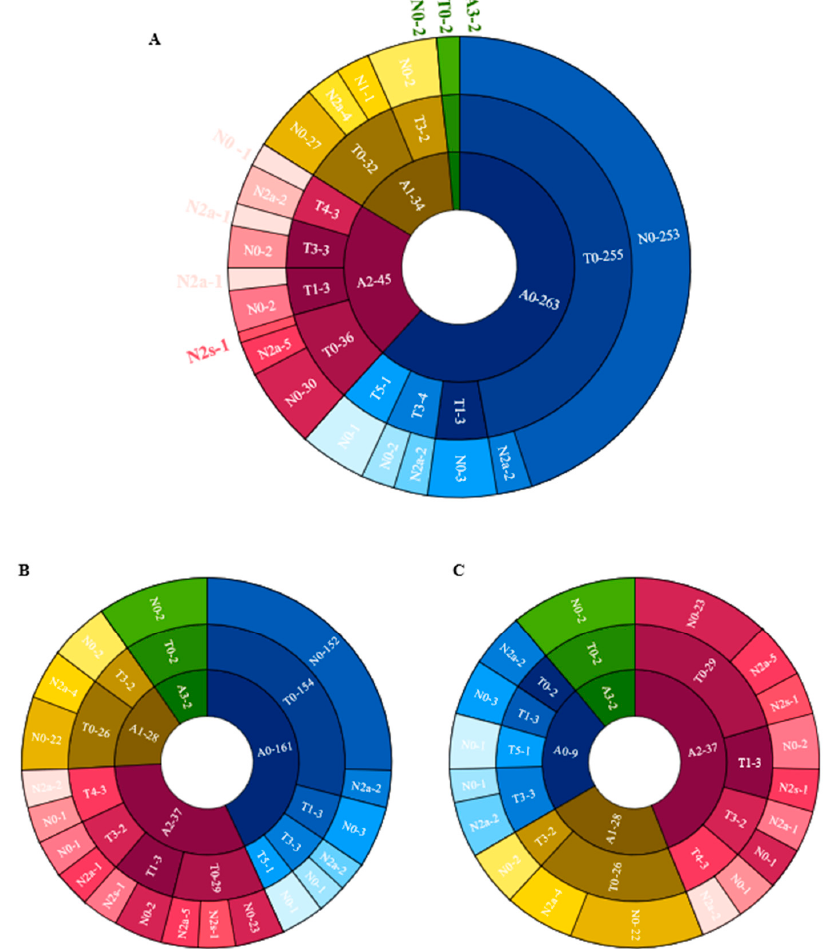
Figure 4. The distribution of different categories of atrophy, traction and neovascularization. ( A ) The distribution of different categories of atrophy, traction and neovascularization in the total cohort. ( B ) The distribution of different categories of atrophy, traction and neovascularization in the Pathological myopic group. ( C ) The distribution of different categories of atrophy, traction and neovascularization in participants with maculopathy.